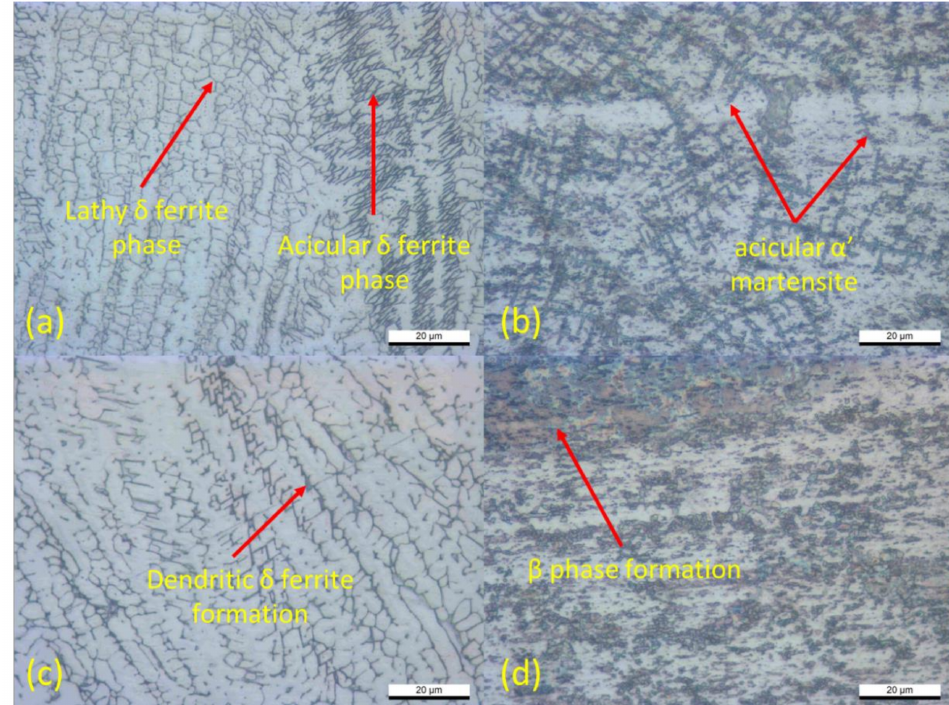
Figure 8. Microstructure of the fusion zone: ( a ) SS316L-sample 1; ( b ) Ti 6 Al 4 V -sample 1; ( c ) SS316L-sample 3; ( d ) Ti 6 Al 4 V -sample